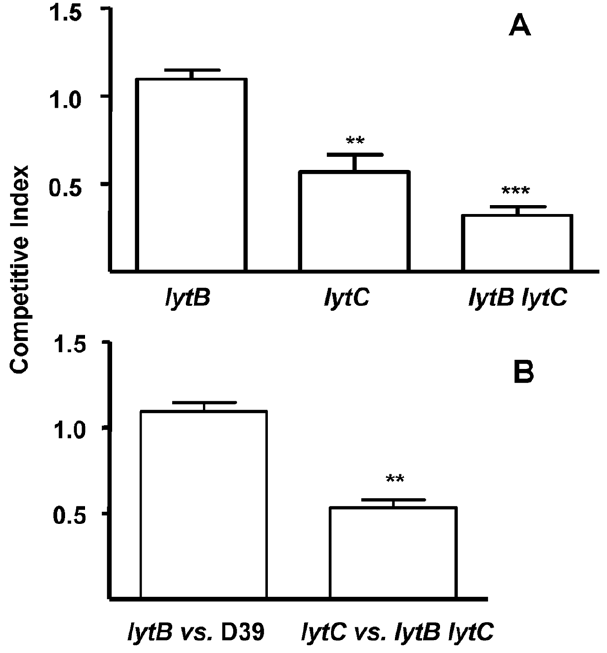
Figure 6. Role in virulence of the different strains using a sepsis model of infection. (A) Virulence represented as a competitive index (CI) of lytB , lytC and lytB lytC strains compared to their parental D39 wild-type strain. Error bars represent SDs of the means. For the comparisons of the results of the CI of the lytC strain vs. lytB **, P , 0.01 (two-tailed Student’s t test). For the comparisons of the double lytB lytC strain vs. the single lytB or lytC strains ***, P , 0.001 and *, P , 0.05 respectively (two-tailed Student’s t test). (B) CIs of lytB strain compared to strain D39 and CIs of lytB lytC mutants compared to lytC strain to assess the combined effect of LytB and LytC in sepsis. **, P , 0.01 for the comparison of both CIs (two-tailed Student’s t test).